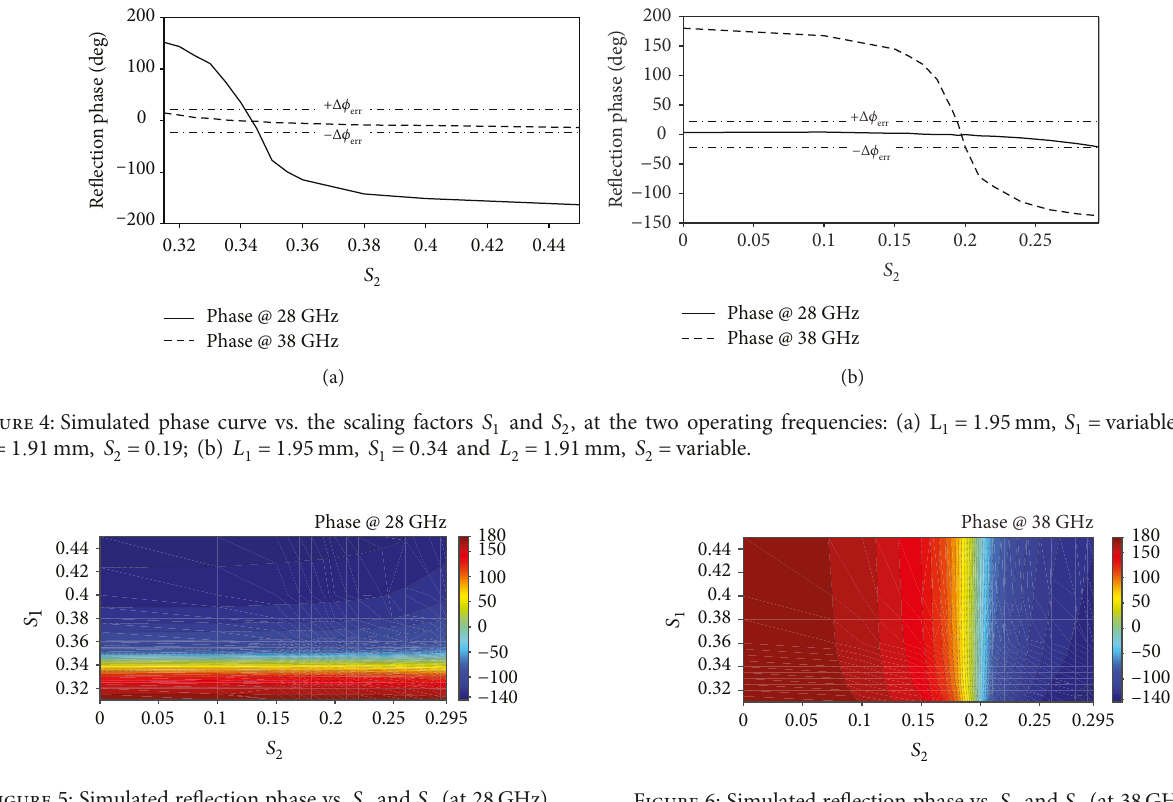
Figure 6: Simulated re fl ection phase vs. S